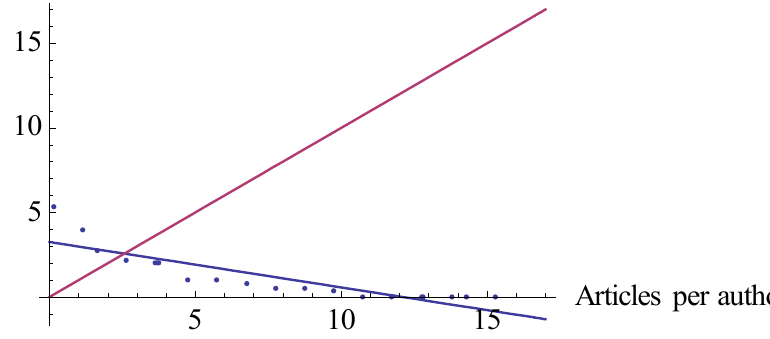
Figure 3. Least-squares linear interpolation fitting for the H index per author per year (i.e., scientific productivity): H lyn10 = 2.56 ( R 2 = 0.72; regression sum of squares = 30; sum of squares for the residuals = 11; F (2, 18) = 46 ( p < 0.001) with 2 parameters and 20 observations). The red increasing linear line represents y = x ; the blue decreasing line represents the fitted curve. Abbreviations: l = linear interpolation; y = publications and citations per year, n = net citations; 10 = 10 years (2007 to 2016).